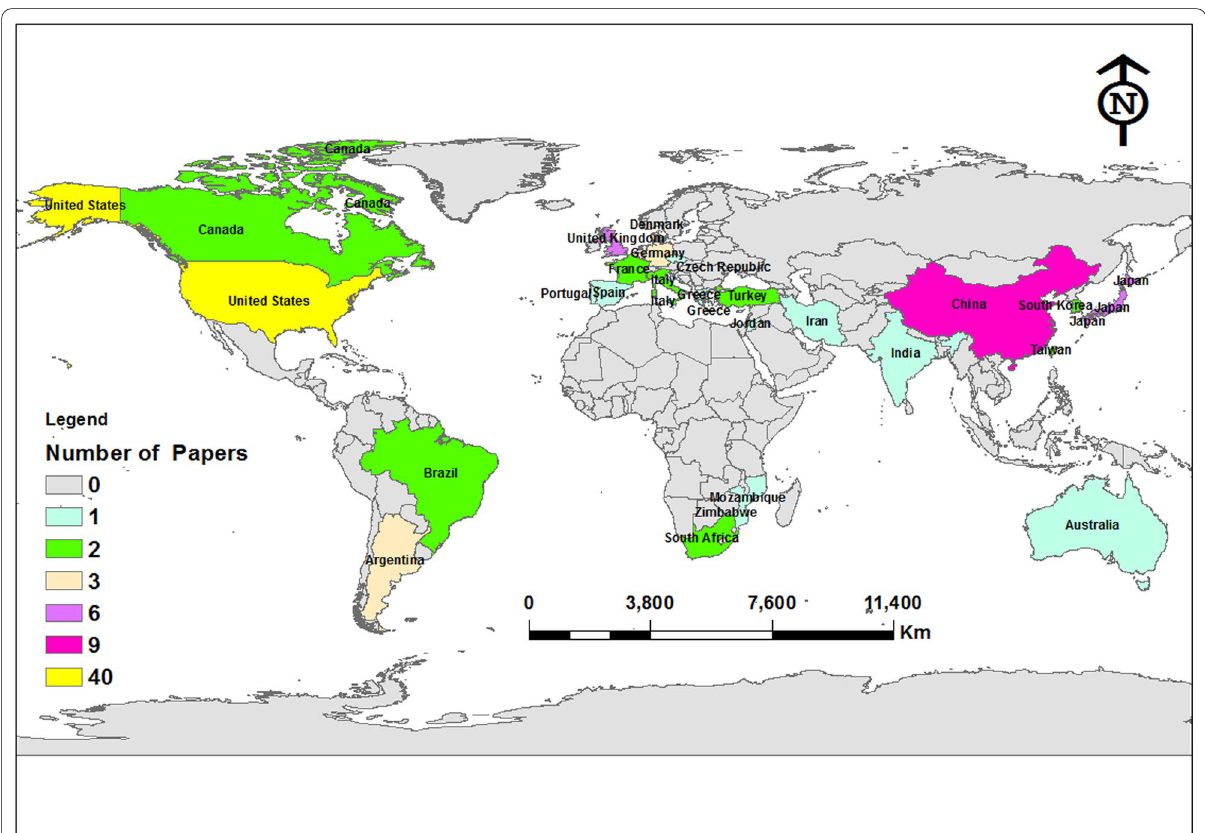
Fig. 5 Spatial distribution of researches conducted on EDCs abundance, exposure, and impact on reproductive